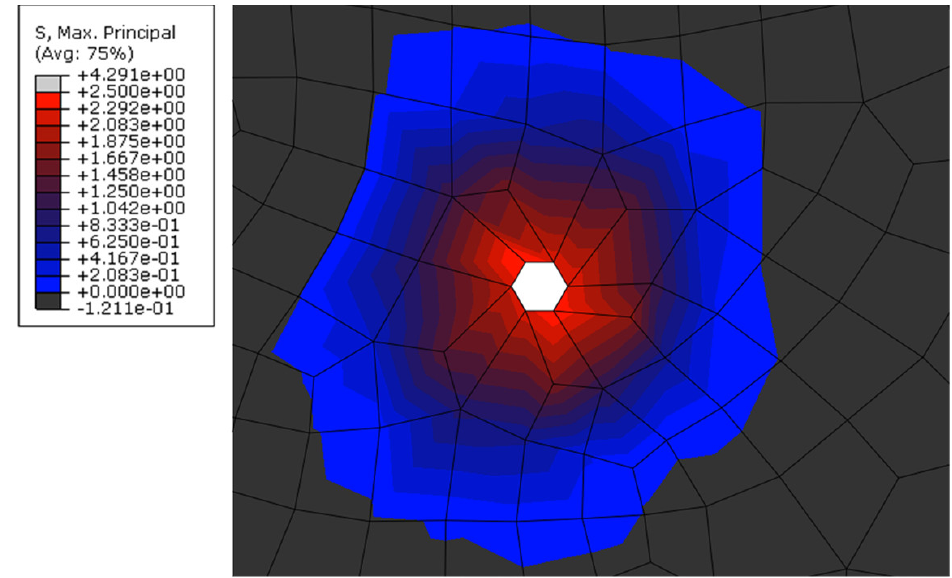
Figure 13. Maximum principal stresses of mortar around the single steel cord.